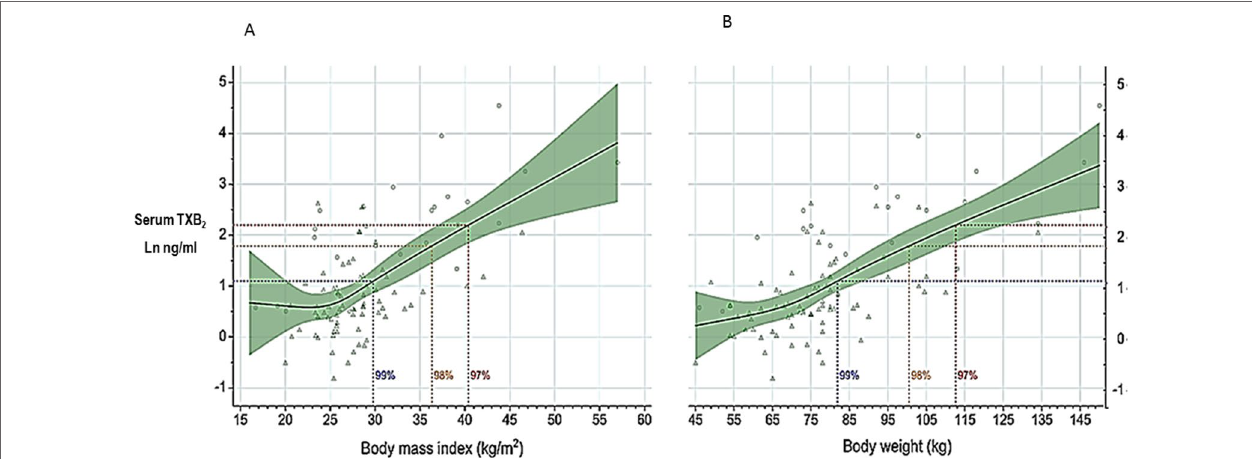
FIGURE 5 | Serum thromboxane (TX)B 2 levels at 24 h after aspirin intake (100 mg once daily) vs body mass index or body weight. Log-transformed serum TXB 2 levels measured 24 h after a witnessed aspirin intake are represented in relation to body mass index (panel A ) and body weight (panel B ). Triangles represent individual patients receiving aspirin for primary or secondary cardiovascular prevention, n = 71; circles represent individual healthy subjects, n = 25. Solid lines and green areas: predicted serum TXB 2 levels and 95% confidence intervals, respectively, as a function of increasing body mass index (panel A ) and body weight (panel B ) in the 96 study subjects. Horizontal dotted lines were drawn to indicate serum TXB 2 levels of 3, 6, and 9 ng/mL, corresponding to 99%, 98%, and 97% inhibition of platelet COX-1 activity, respectively, measured in healthy subjects. The vertical dotted lines were drawn to indicate on the abscissa scales the highest calculated values of body mass index (panel A ) and body weight (panel B ) compatible with these different levels of platelet COX-1 inhibition. Modified and redrawn from Petrucci et al., 2019, with permission from the